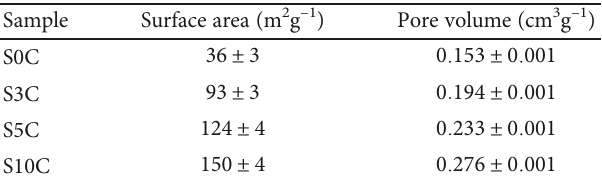
Figure 2: (a) N adsorption-desorption isotherms and (b) BJH pore size distribution of S0C, S3C, S5C, and S10C (thermally treated at 500 ° C). 2 Inset in (b): the DFT pore size distribution. Table 1: Surface area and pore volume from the samples thermally treated at 500 °